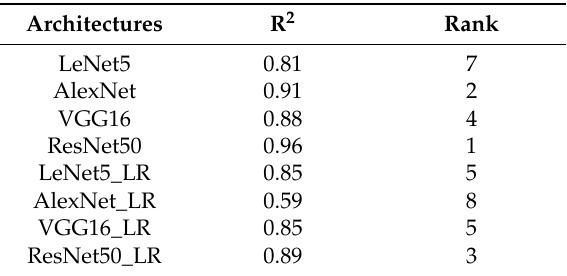
Table 3. R 2 of the prediction model for each